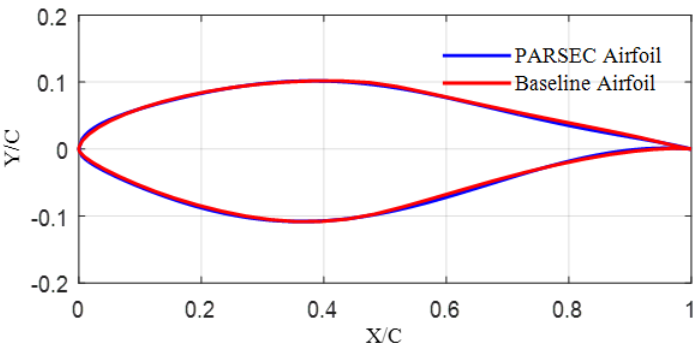
Figure 3. NREL S809 airfoil generated by PARSEC parameterization.